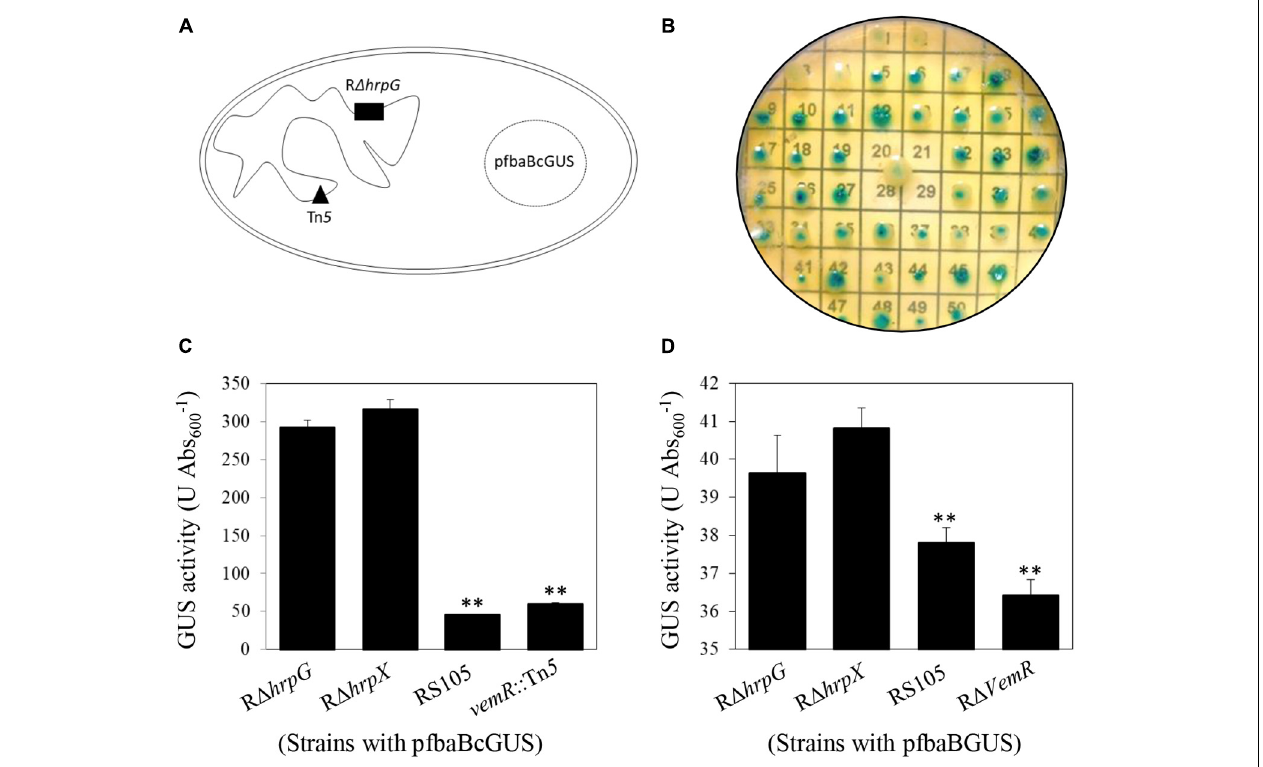
FIGURE 1 | Transcriptional repression of v emR by HrpG in X. oryzae pv. oryzicola ( Xoc ). (A,B) Schematic representation of Tn 5 mutagenesis strategy in Xoc to identify signaling genes acting upstream of HrpG in Xoc strain R ρ hrpG /pfbaBcGUS. (C,D) Enzymatic GUS activity (mean ± standard deviation) in the selected Tn 5 mutant strain vemR :Tn 5/ pfbaBcGUS and the non-polar deletion strain R ρ vemR /pfbaBGUS, respectively. Student t -test ( p = 0.01) was used to separate the significantly different means (denoted by **) relative to the parental R ρ hrpG strain used for Tn 5 mutagenesis.